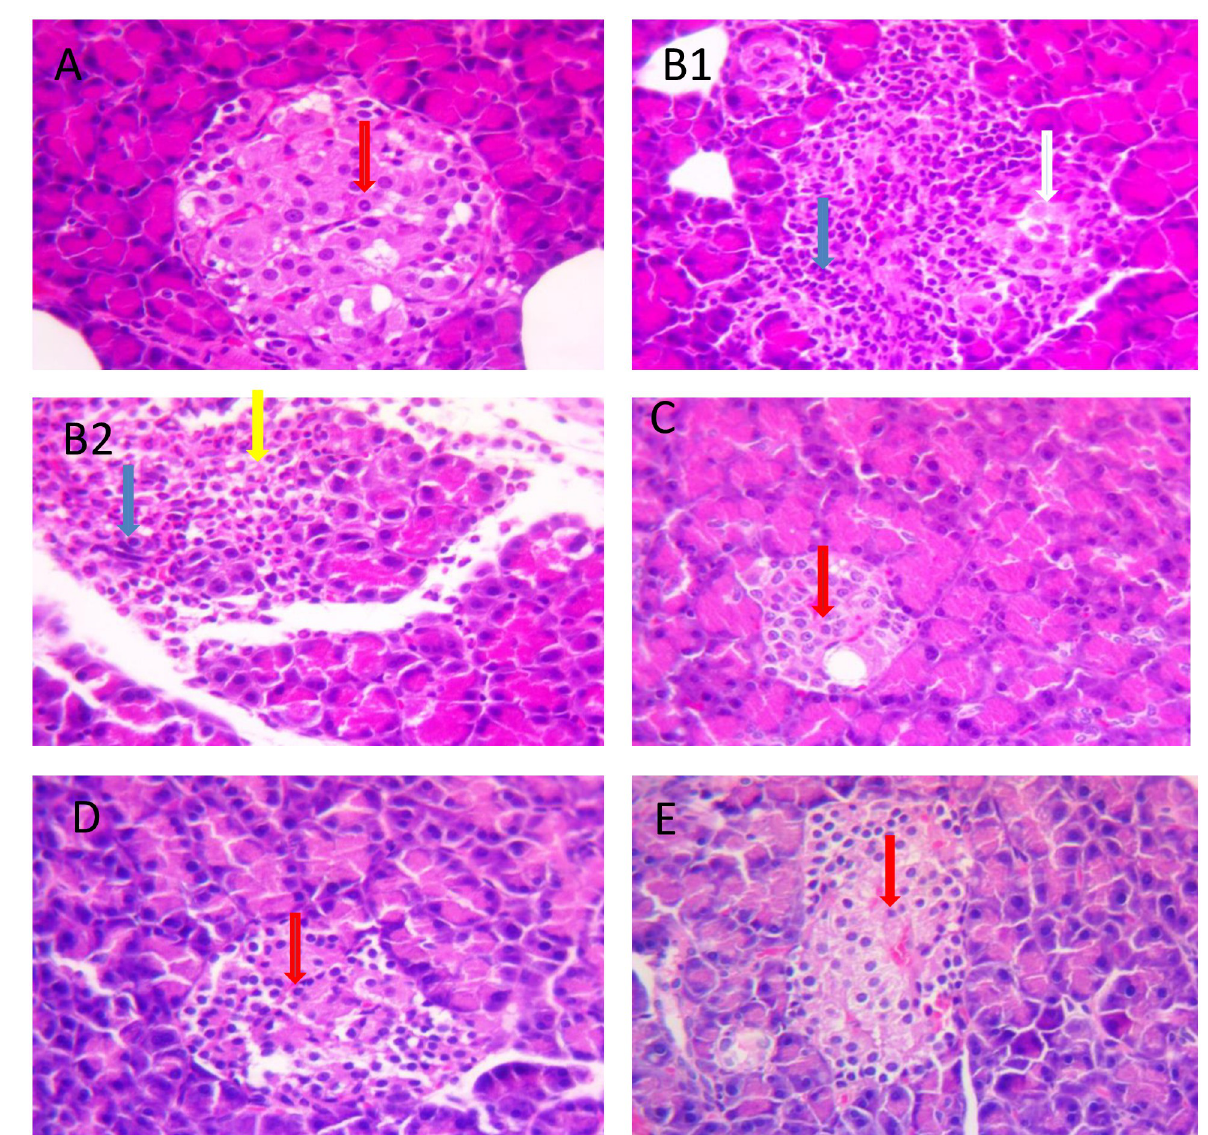
Fig 3. Effect of GLB or MEOAL on histopathological changes of pancreatic tissue in different groups. Hematoxylin and Eosin staining sections under 40X magnification. https://doi.org/10.6084/m9.figshare.21828810.v2. Photomicrograph of the pancreas from; (A) Normal control group showing the normal histological architecture of the pancreas with intact and centrally located β -cells (red arrow); (B1&B2) Diabetic control group showing distortion of the islet with prominent necrotic β -cells (yellow arrow), Degenerative alterations in β -cells (white arrow) and inflammatory cells infiltration mainly lymphocytes (blue arrow) have been observed; (C) Diabetic GLB (5mg/kg) treated group showing partial recovery of the tissue with a moderate increase in the number of the β -cells (red arrow); (D) Diabetic MEOAL (200mg/kg) treated group showing partial recovery of the tissue with a moderate increase in the number of the β -cells (red arrow); (E) Diabetic MEOAL (400mg/kg) treated group showing a dramatic recovery of the tissue with a marked increase in the number of the centrally located β -cells (red arrow). Abbreviation: MEOAL; O . acanthium extract. GLB: